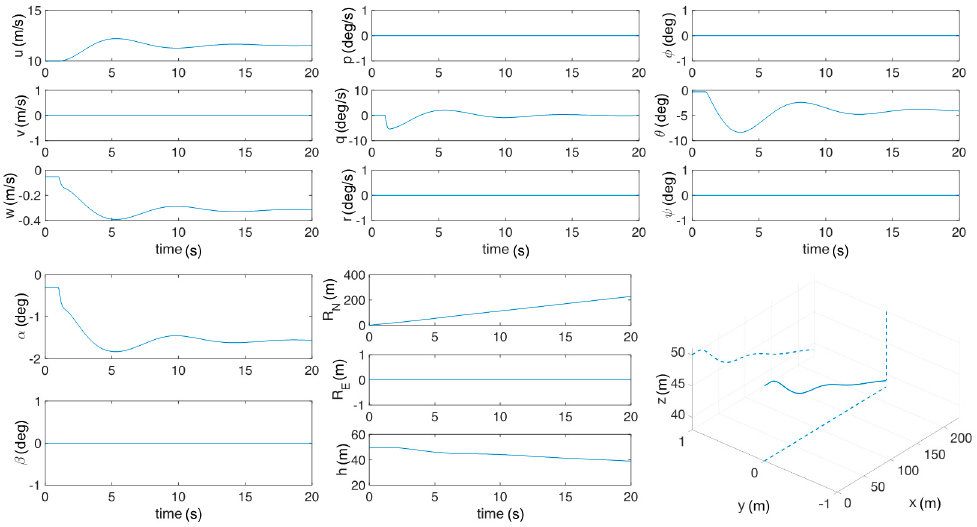
Figure 8. UAV response to the unit step elevator.